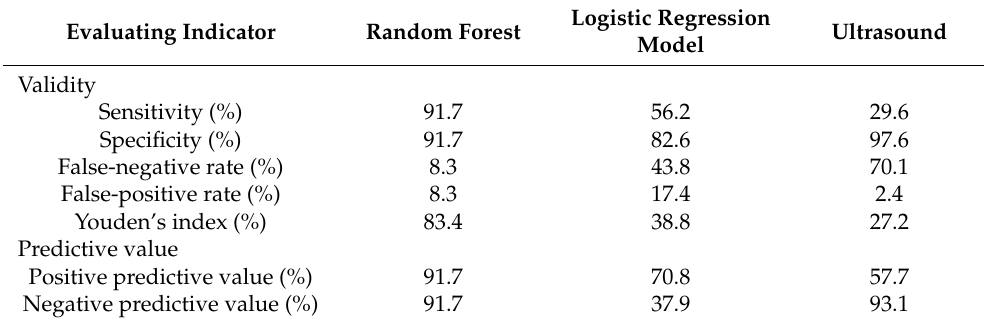
Figure 4. The receiver operating characteristic curve of the three methods. ( a ) shows the ROC curve of the random forest model in predicting macrosomia. ( b ) shows the ROC curve of the logistic regression in predicting macrosomia. Table 2. The comparison of the random forest, logistic regression model, and B-ultrasound in the prediction of